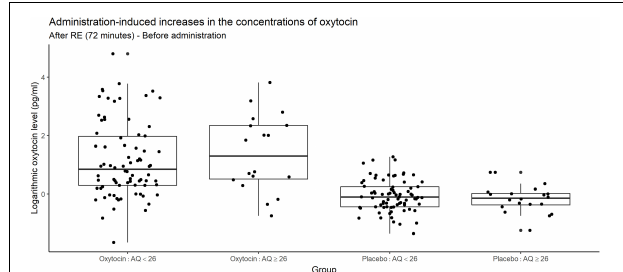
FIGURE 8 | Box plots of administration-induced increases in oxytocin concentration, stratified according to autism quotient (AQ) score. For each plot, the middle horizontal line denotes the median value; the box extends from the 25th to the 75th percentile values; the vertical lines extending from the box denote adjacent values (i.e., the most extreme values within 1.5 interquartile of the 25th and 75th percentile of each group); and the dots denote oxytocin concentration per investor. The figure reveals substantial variation among participants receiving oxytocin in both the higher- and lower-AQ subgroups. The change in salivary oxytocin concentration was measured as the difference between two time points: before administration of oxytocin and after the risk experiment. Certain participants exhibited large increases in the oxytocin concentration, whereas others exhibited very small